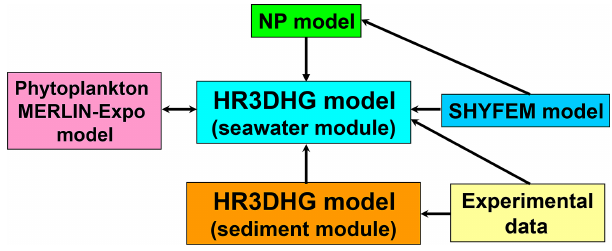
Figure 2. Basic structure of the HR3DHG